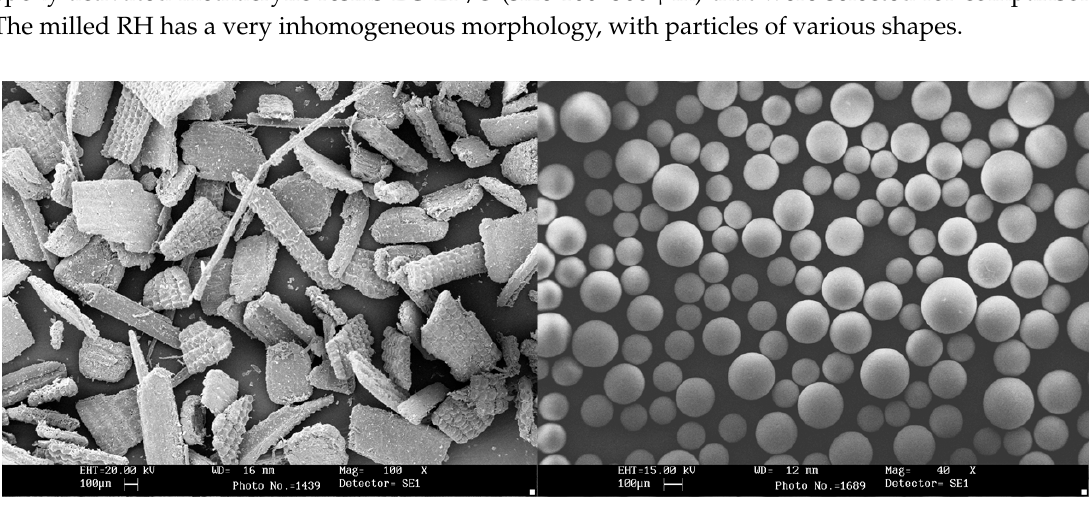
Figure 8. SEM images of: ( a ) Milled rice husk with average particle size 200–400 µm; ( b ) Sepabeads EC-EP epoxy methacrylic resin beads with average particle size 100–300 µm.